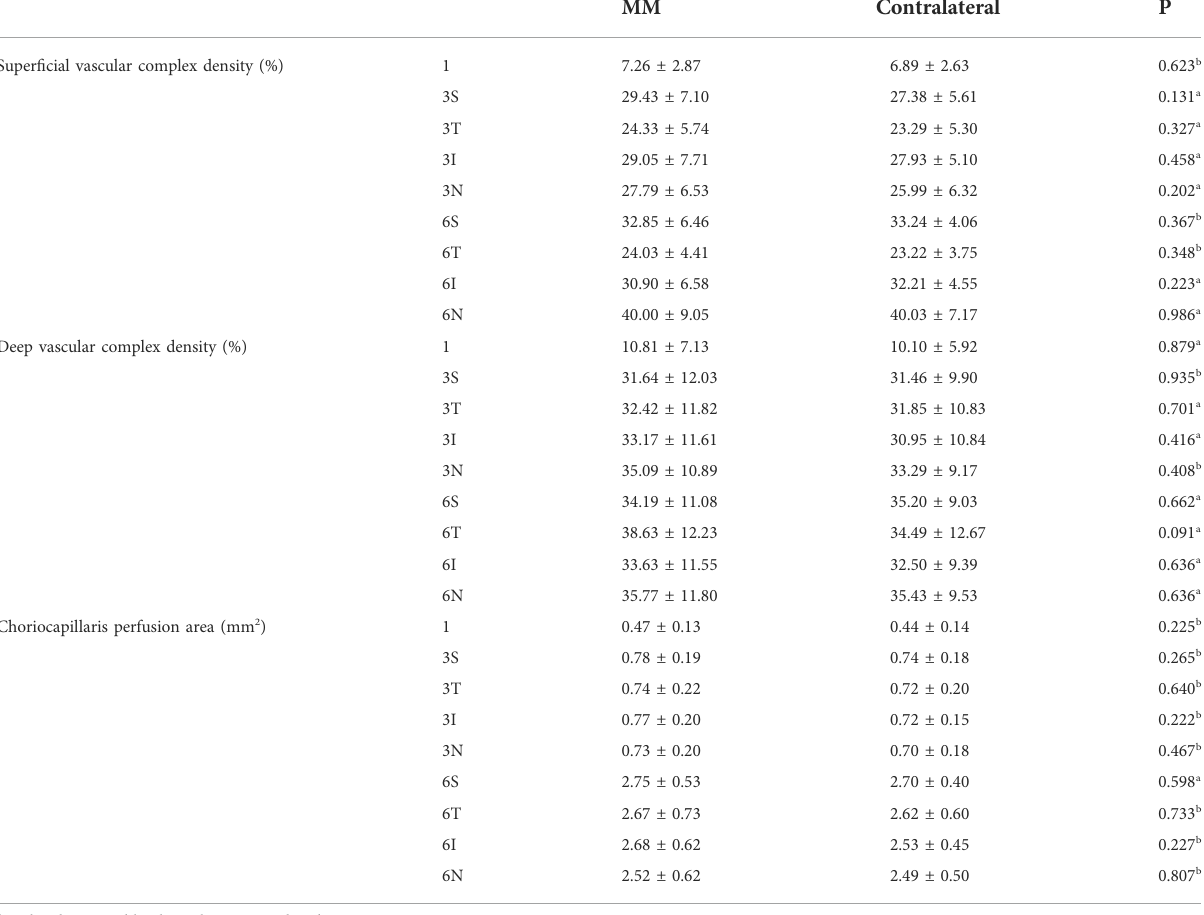
TABLE 3 Comparison of the retinal vascular density and choriocapillaris perfusion area of more myopic and contralateral